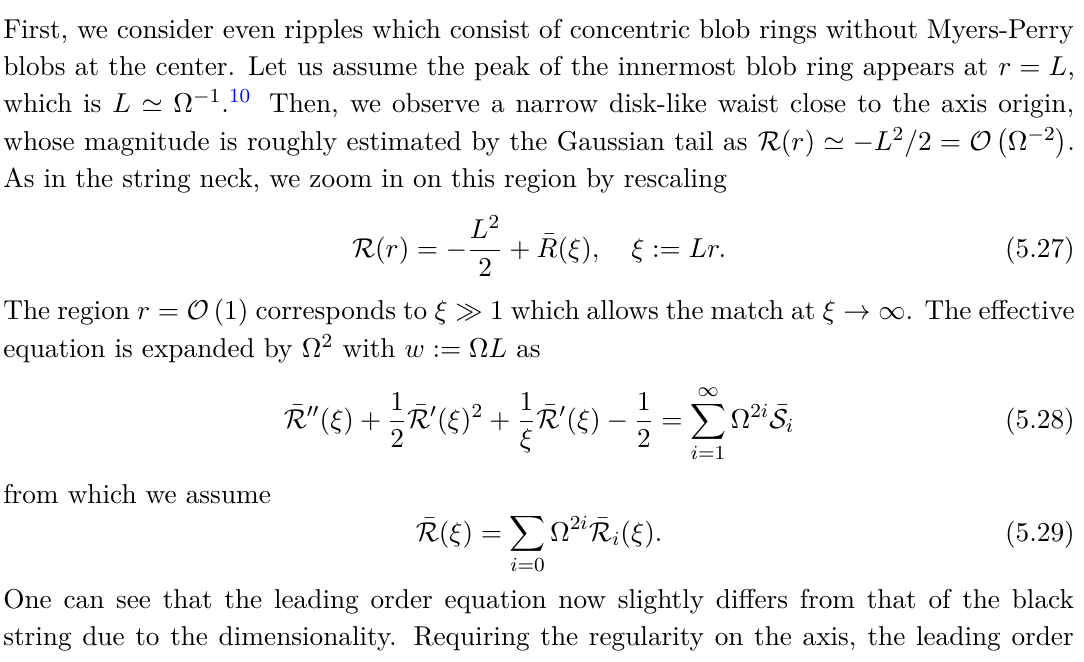
Figure 9 . The normalized separation between blob rings (left) and normalized average peak position (right). In each panel, the solid curve is the numerical result. In the left panel, NLO and NNLO results for s = 2 , 3 are plotted as dashed and thin curves. The separations for s = 3 are degenerate up to NNLO. In the right panel, the blob approximation up to O a dashed curve. The odd solutions share the same curve as the corresponding even ones until the point where non-perturbative effects become important. The numerical data are produced with the same method used in ref.